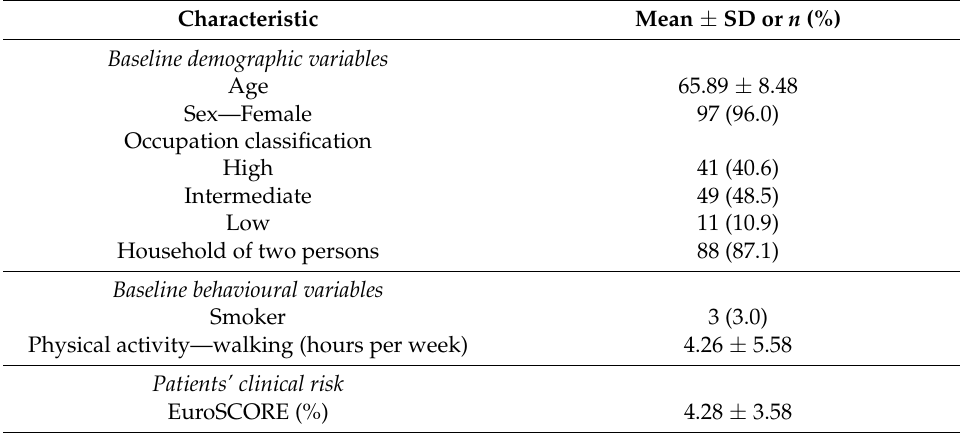
Table 1. Baseline characteristics of the sample (N = 101).